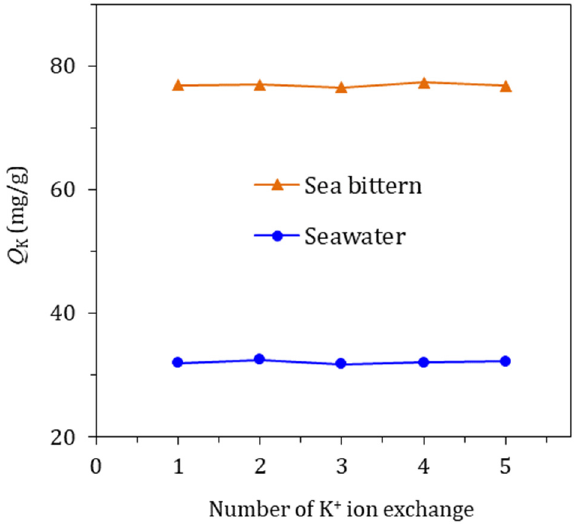
Figure 6. Reusability of KCHA zeolite membrane.